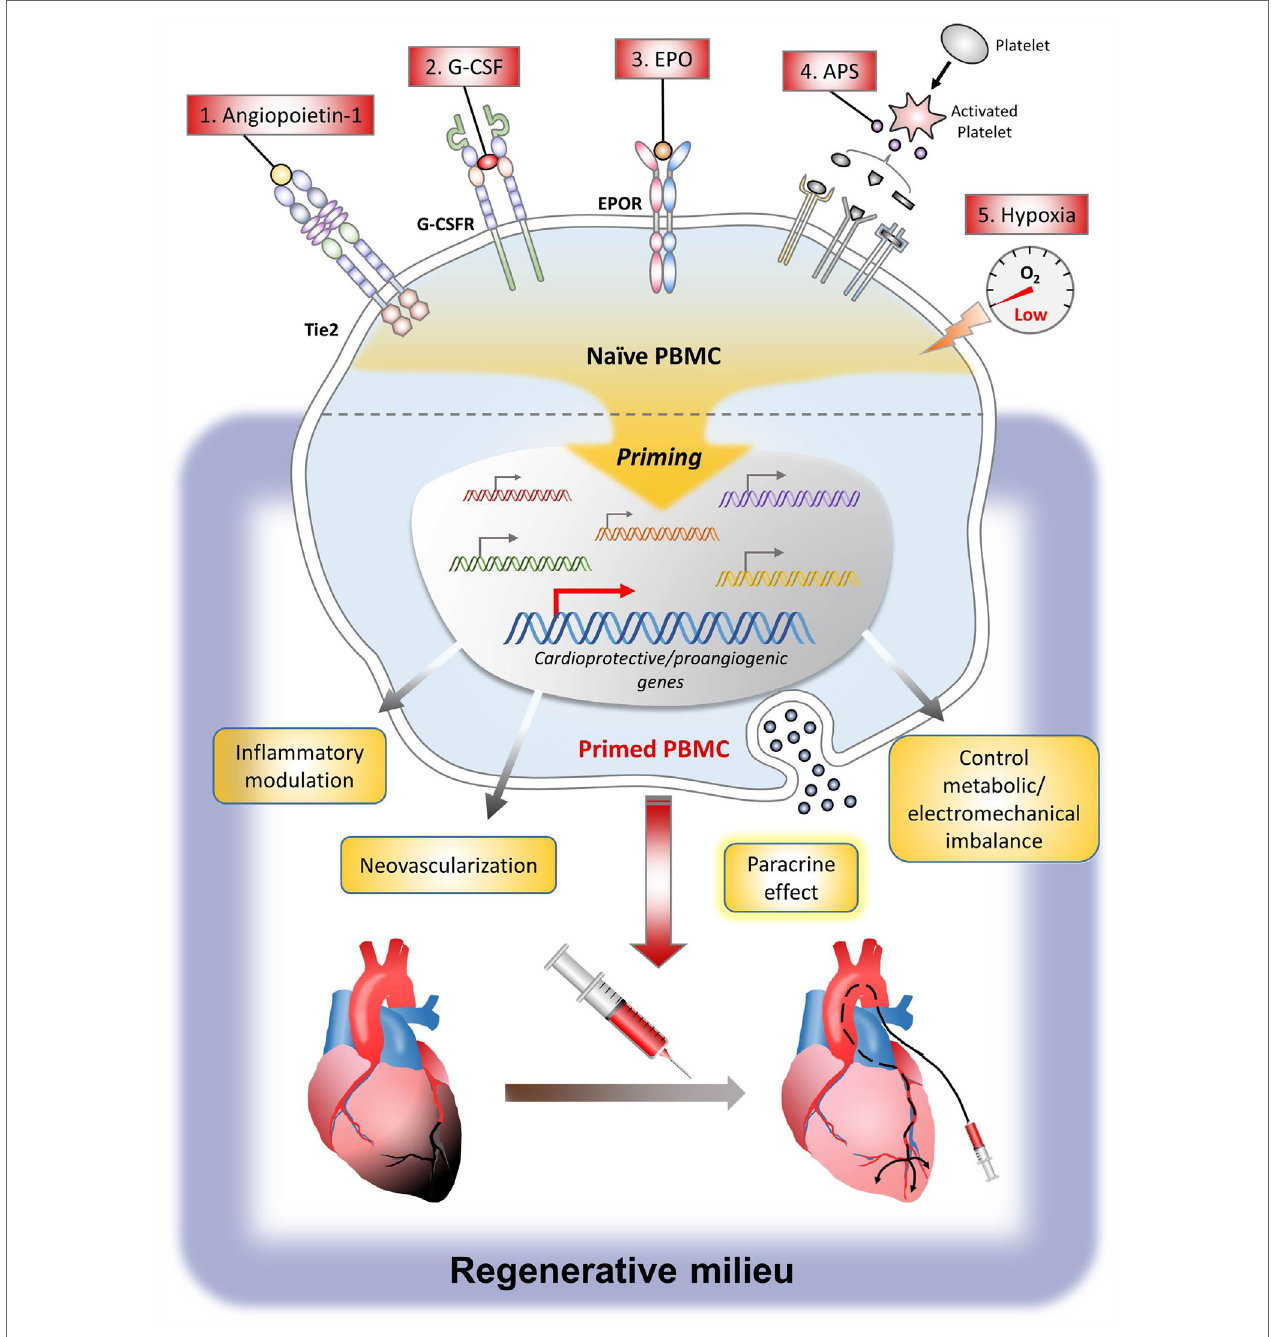
FiGURe 1 | Scheme of the cellular effects of priming agents .